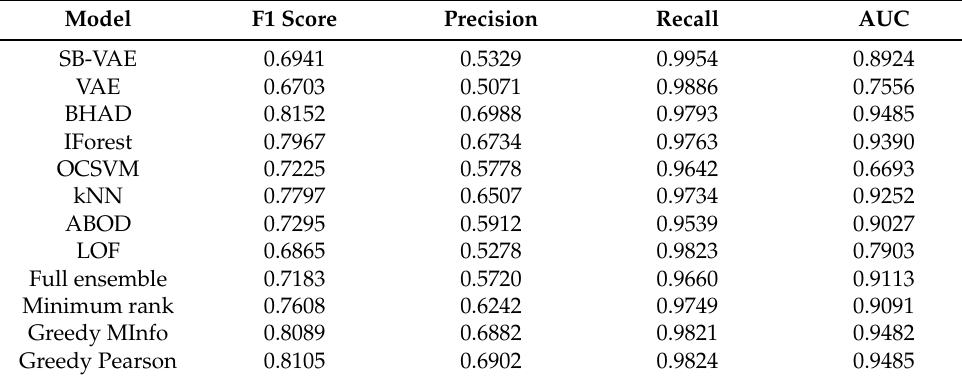
Table 3. Results: Wisconsin-Breast Cancer (Diagnostics)